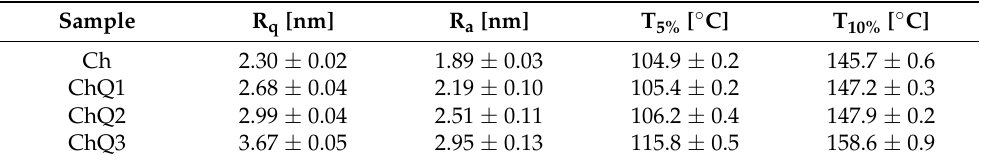
Table 2. Values of roughness root mean square roughness (R q ) and roughness average (R a ) parameters and thermal stability of studied